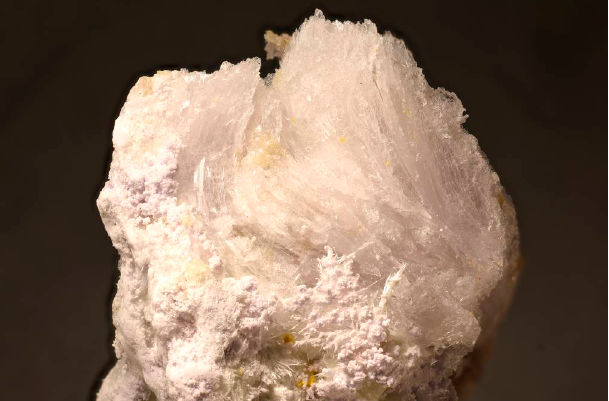
Figure 5. Alunogen from the Monte Arsiccio mine, as white fibrous aggregates formed by tabular individuals, up to 4 cm long.